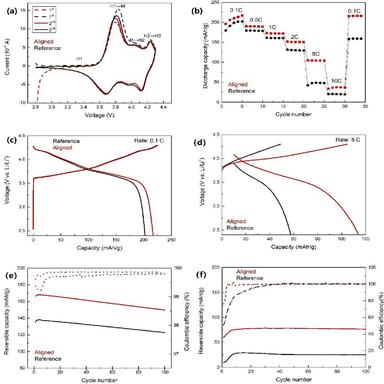
(a) Cyclic voltammograms of the Aligned and Reference electrodes at a scan rate of 0.1 mV/s; (b) Rate performance of the Aligned and Reference electrodes; (c) and (d) galvanostatic charge discharge curves at 0.1 and 5C; (e) cycling performance and coulombic efficiency of the Aligned and Reference electrodes at 1C, and (f) at 5C.